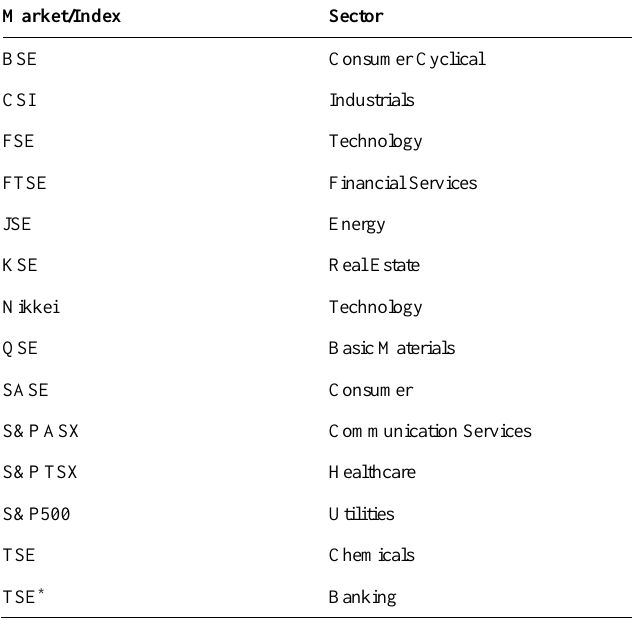
Table 17. The main information receiver sectors, before